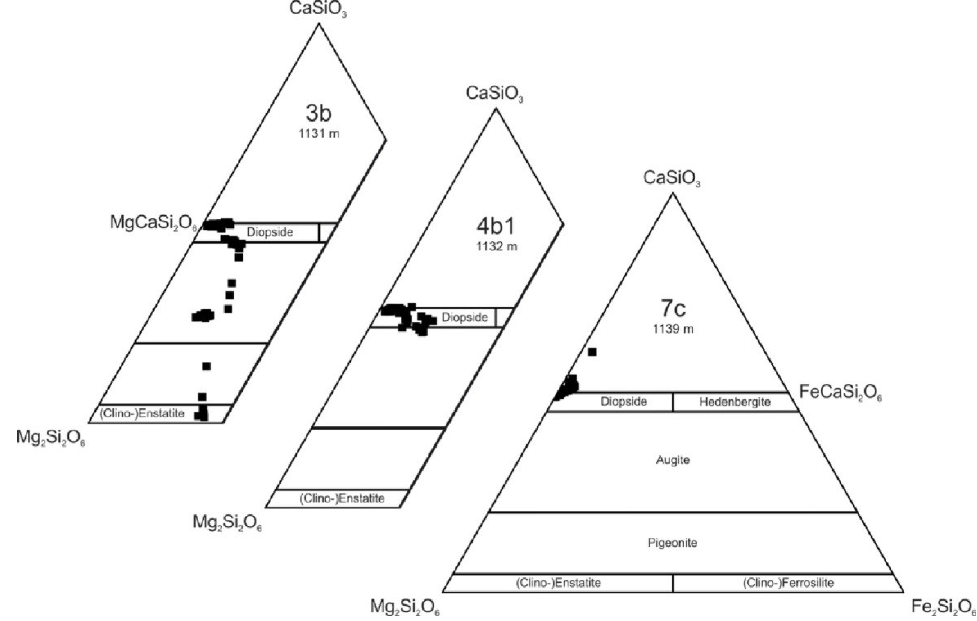
Figure 4. Calculated pyroxene endmembers (from EMP analysis). The analyses that plot between enstatite and diopside in samples 3B (top left) are across exsolution lamellae.